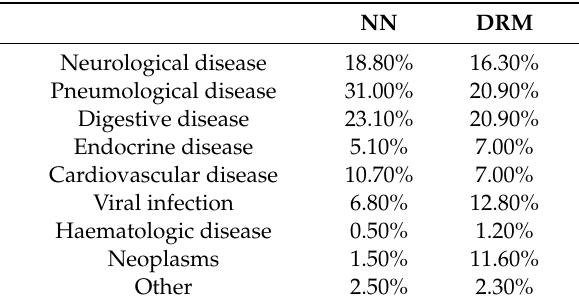
Table 1. Distribution of the di ff erent diseases presented by NN and DRM